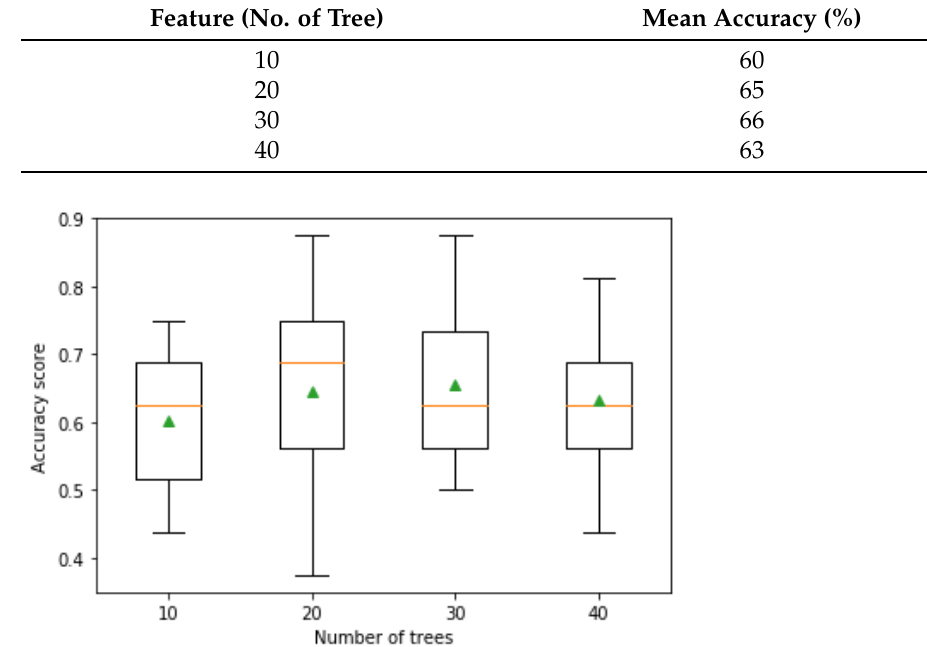
Figure 20. Haiti: Boxplot represents the mean accuracy distribution achieved by tuning the number of trees for every